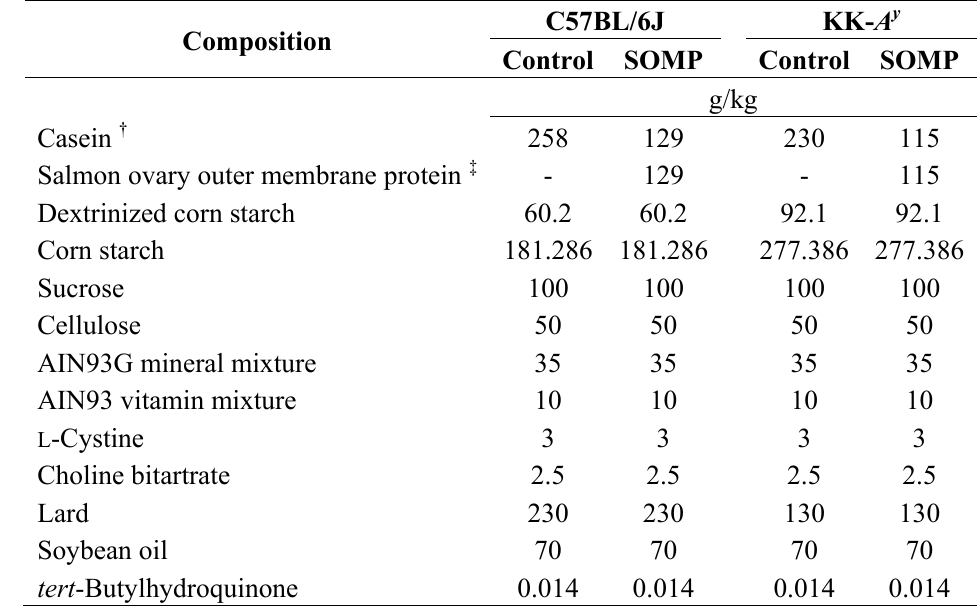
Table 1. Composition of the experimental